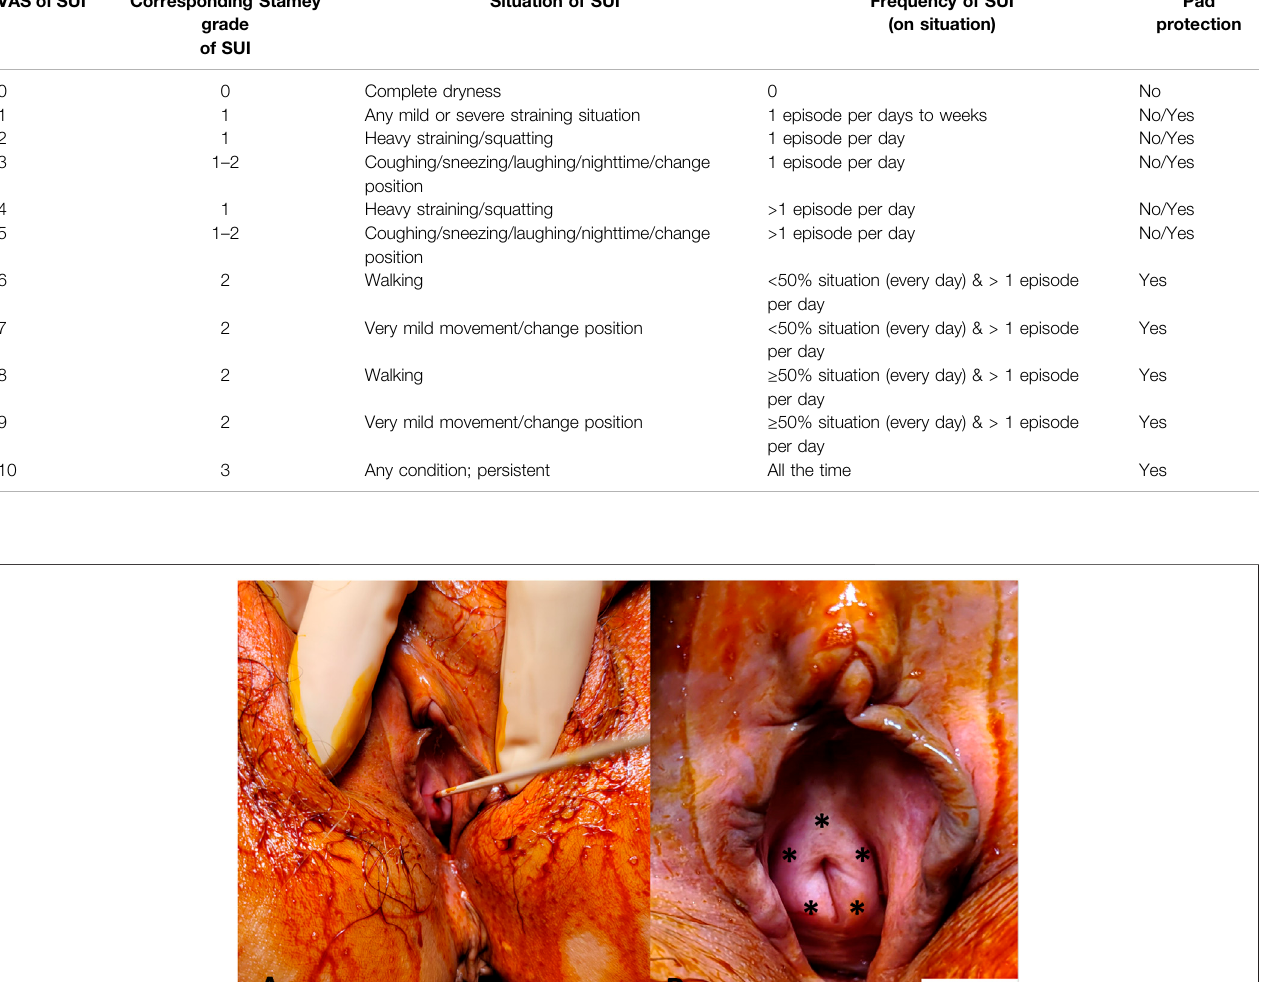
TABLE 1 | Visual analogue scale (VAS) for the assessment of stress urinary incontinence (SUI). VAS of SUI Corresponding Stamey grade